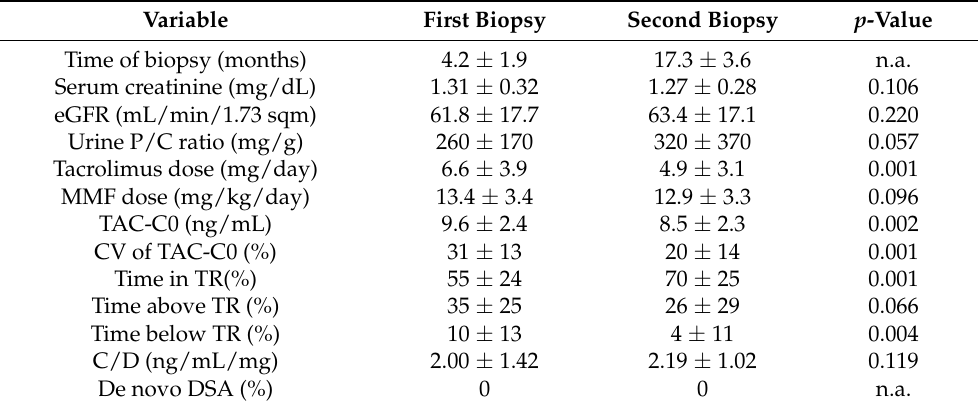
Table 2. Clinical data at the time of the first and second surveillance biopsies of the studied co- hort ( n =